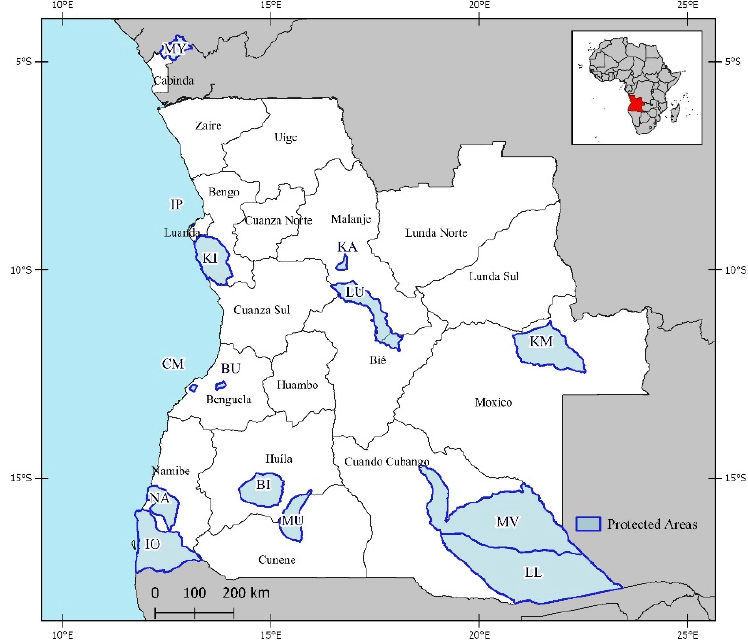
Figure 1. Study area, with the 18 provinces of Angola and the protected areas system: BI, Bicuar; BU, Búfalo; KA, Cangandala; CM, Chimalavera; IO, Iona; IP, Ilheu dos Pássaros; KM, Cameia; KI, Quiçama; LL, Luengue-Luiana; LU, Luando; MV, Mavinga; MU, Mupa; MY, Maiombe; NA, Namibe.